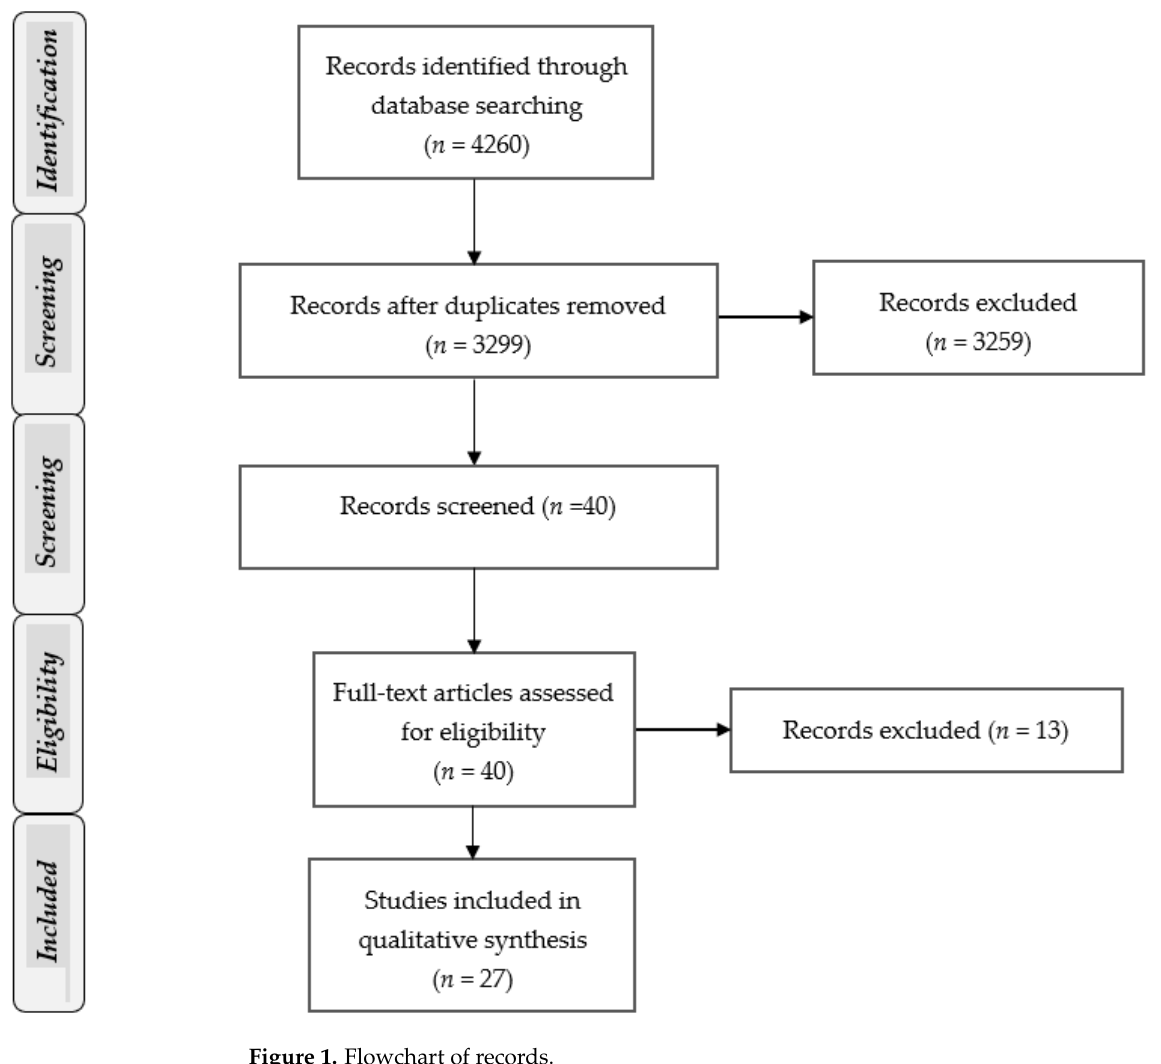
Figure 1. Flowchart of